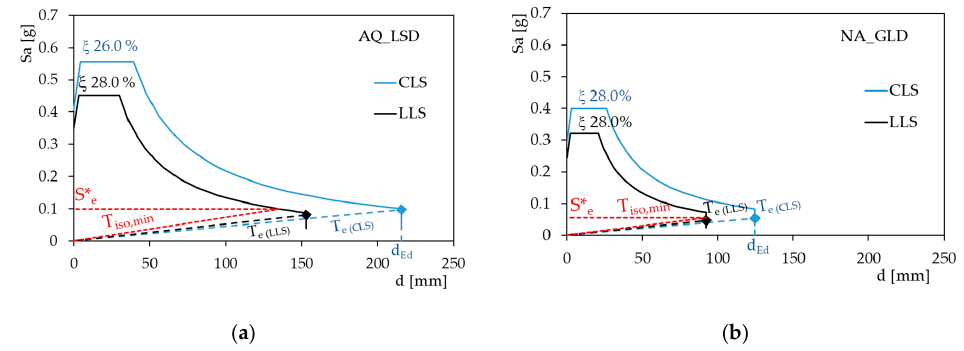
Figure 6. Elastic limits from pushover curves of existing buildings and isolation system design procedure for the cases of L’Aquila ( a ) and Naples ( b ).